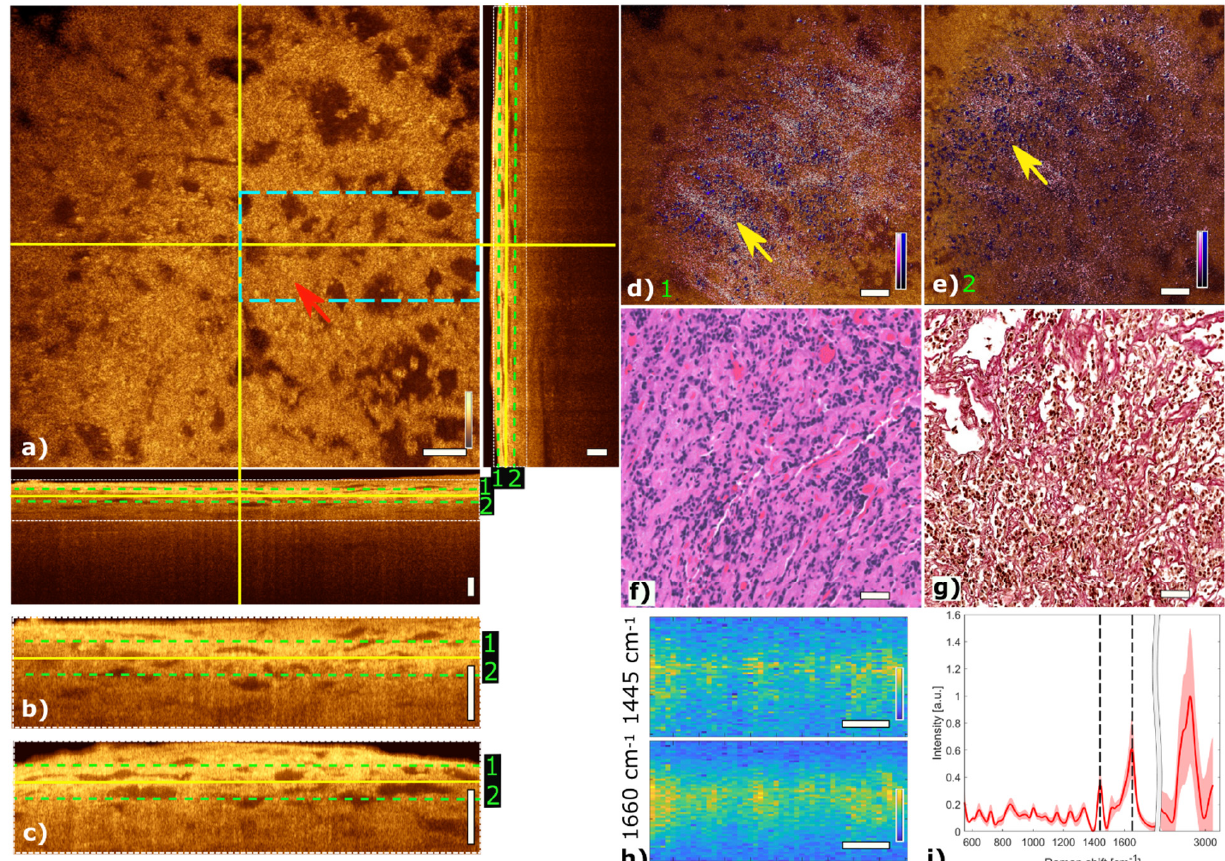
Figure 4. Multimodal investigation of a representative mammosomatotroph adenoma. ( a ) OCT orthogonal view: en face image shows plane at the depth indicated in B-scans (depth profiles) with yellow lines. OCT en face and B-scans were averaged 5 times. Red arrow indicates an area where single cells are visible. The green dashed lines (1 and 2) in the OCT B-scans indicate the position of the overlaid OCT-MPM images. The blue dashed rectangle indicates the region where the LSRM scan was performed. White dotted rectangles in OCT B-scans indicate positions of magnified regions of interest. ( b , c ) Magnified horizontal and vertical OCT B-scans. ( d , e ) MPM combining SHG and TPEF signals overlaid with OCT at different depths. NADH and FAD information (TPEF) reveals contrast corresponding to cells in blue, and SHG provides contrast from the surrounding tissue containing collagen in bright pink, respectively. Yellow arrows indicate single cells